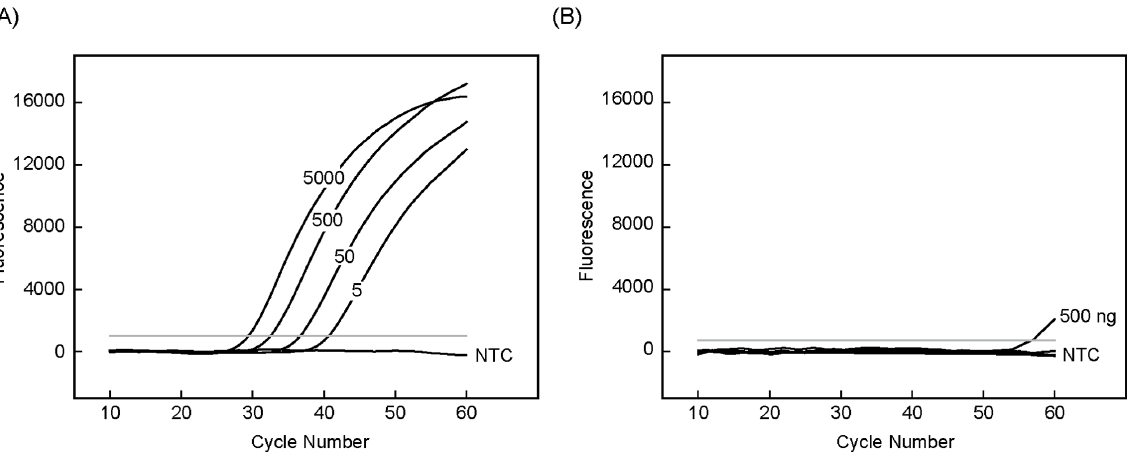
Figure 2. Study on the sensitivity and specificity of the singleplex real-time Bi-PAP. (A) Amplification curves of 5000, 500, 50, 5 copies per reaction (from the left to right) of G12R mutant plasmids. (B) Amplification curves of 500, 100, 10, 1 ng wild-type genomic DNA per reaction. Water was used as non-template control (NTC).